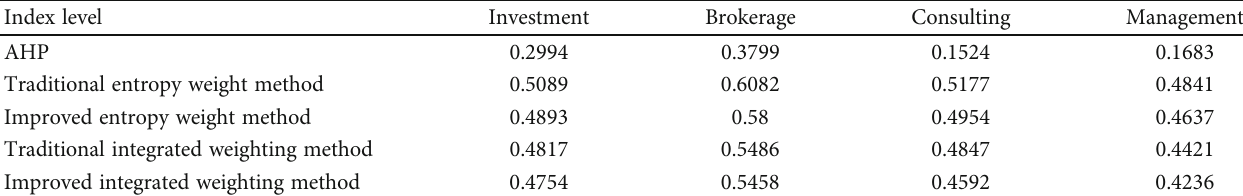
Table 6: Results of performance evaluation of securities industry by di ff erent methods.